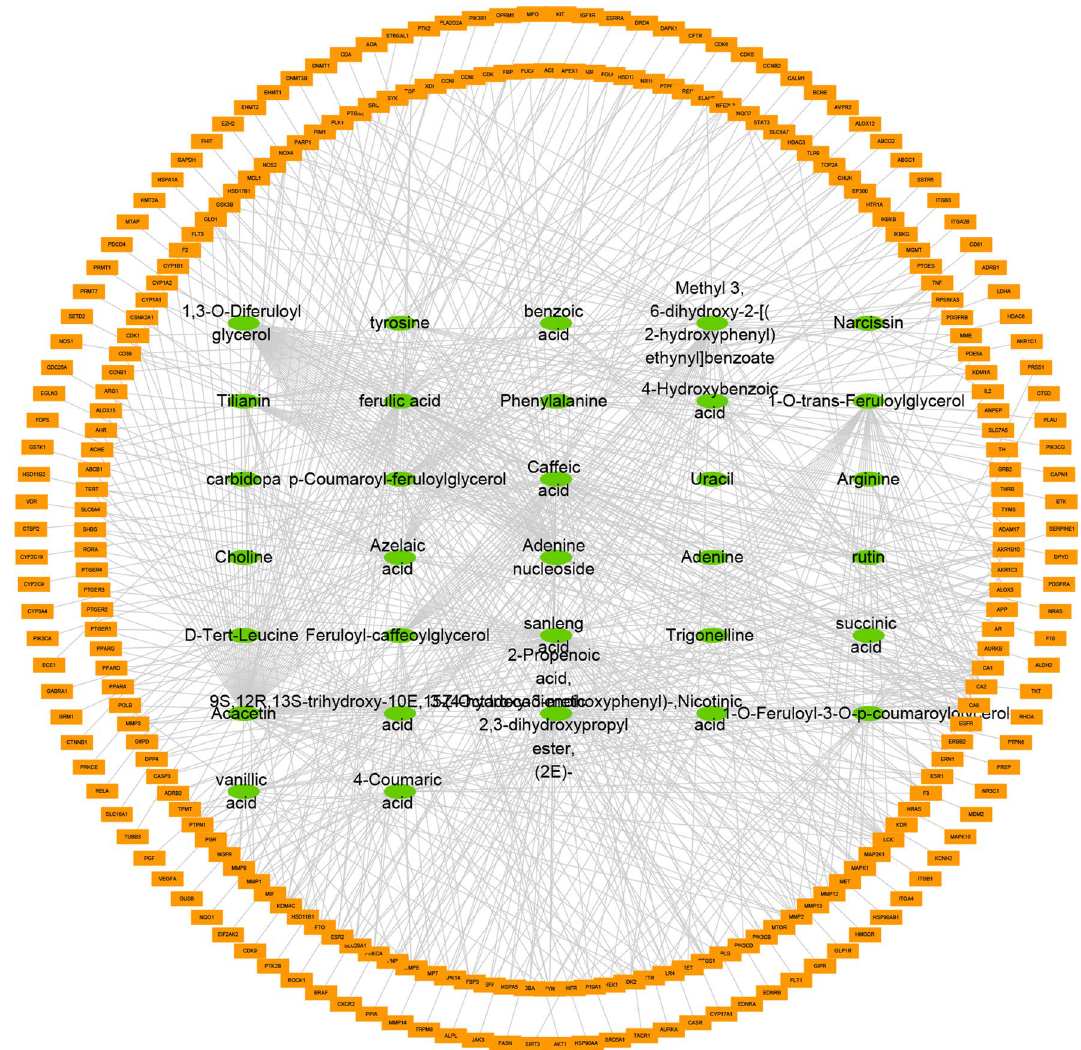
Figure 3. Compound-target network. Green elliptical nodes represent chemical components, and orange rectangular nodes represent